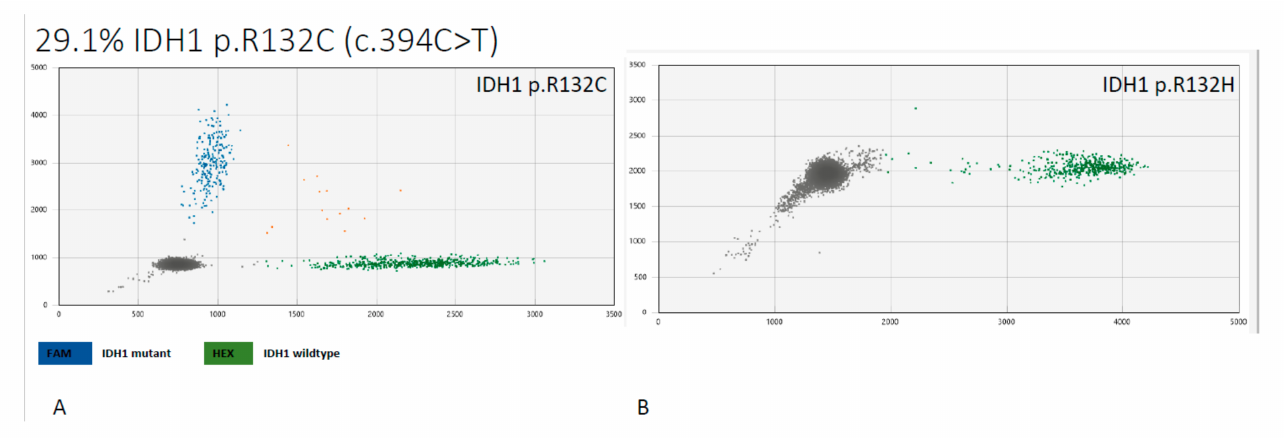
Figure 5. Serum analysis of ctDNA by NGS to detect hotspots mutations IDH1 R132C and IDH1 R132H . Analysis of one patient sample ( A ) with blue spots indicating detection of IDH1 R132C ctDNA that consists of 29% ctDNA, ( B ) IDH1 R132H was not